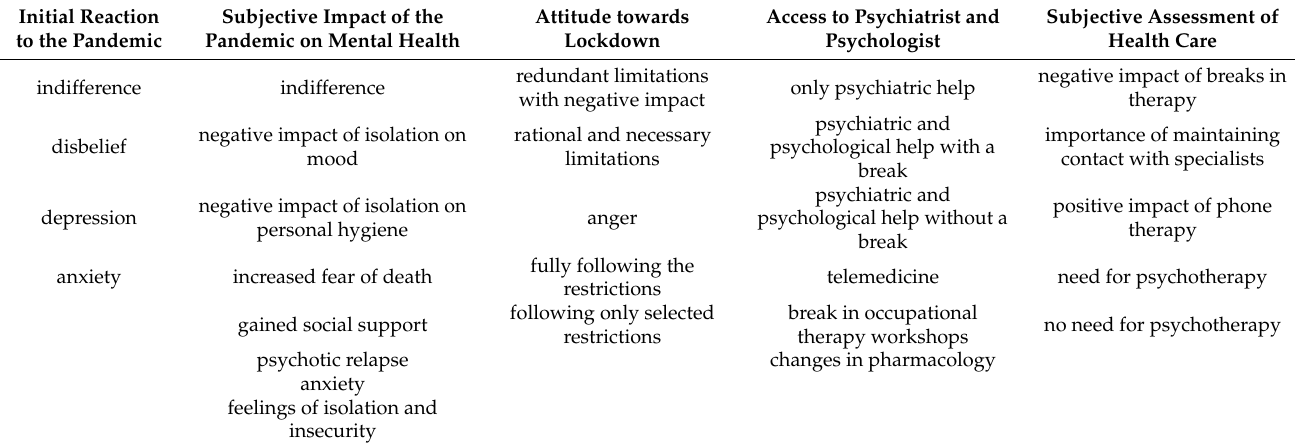
Table 3. Summary of the most common topics in patients’ reactions to the